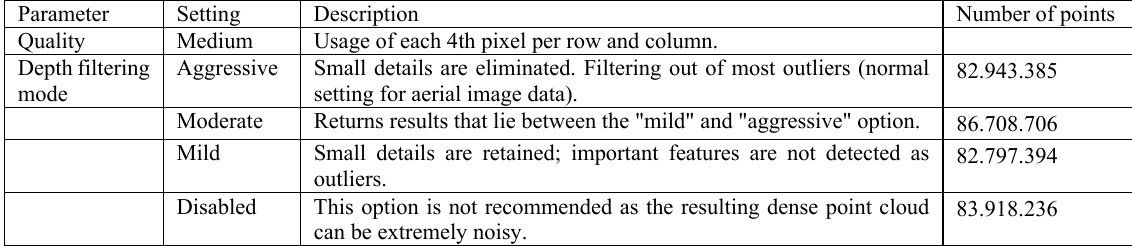
Table 1: Parameterization of the dense point clouds in Agisoft PhotoScan – as described by the software developer (Agisoft